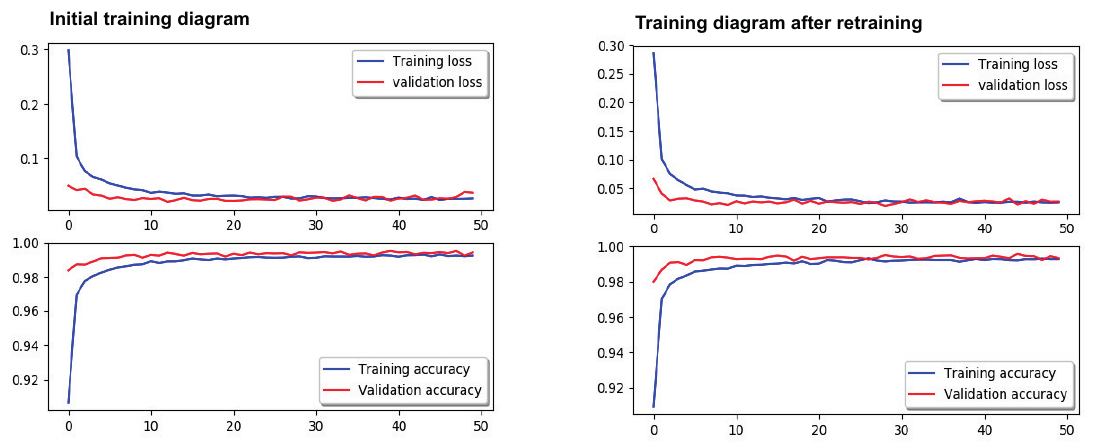
Figure 7. Training diagram of NN recognition after initial and second